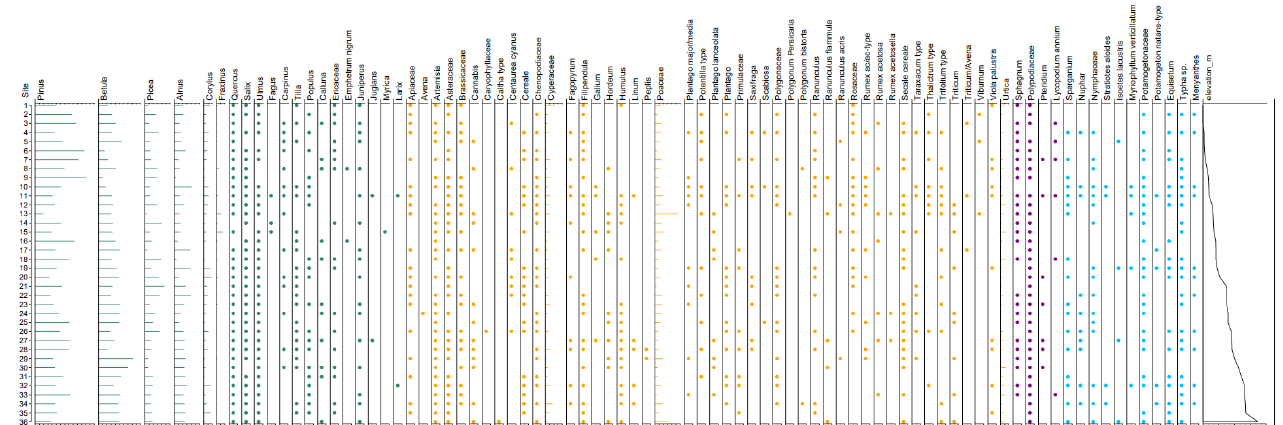
Figure 4. Pollen percentages diagram showing all pollen and spores identified from 36 lake and pond samples alongside altitudinal gradient. Values on horizontal axes are percentages. Shading in gray is an exaggeration at ×10 for pollen data to ease visibility of low percentage values of taxa particularly. Site names for appropriate number see Figure 1 and Table 1.